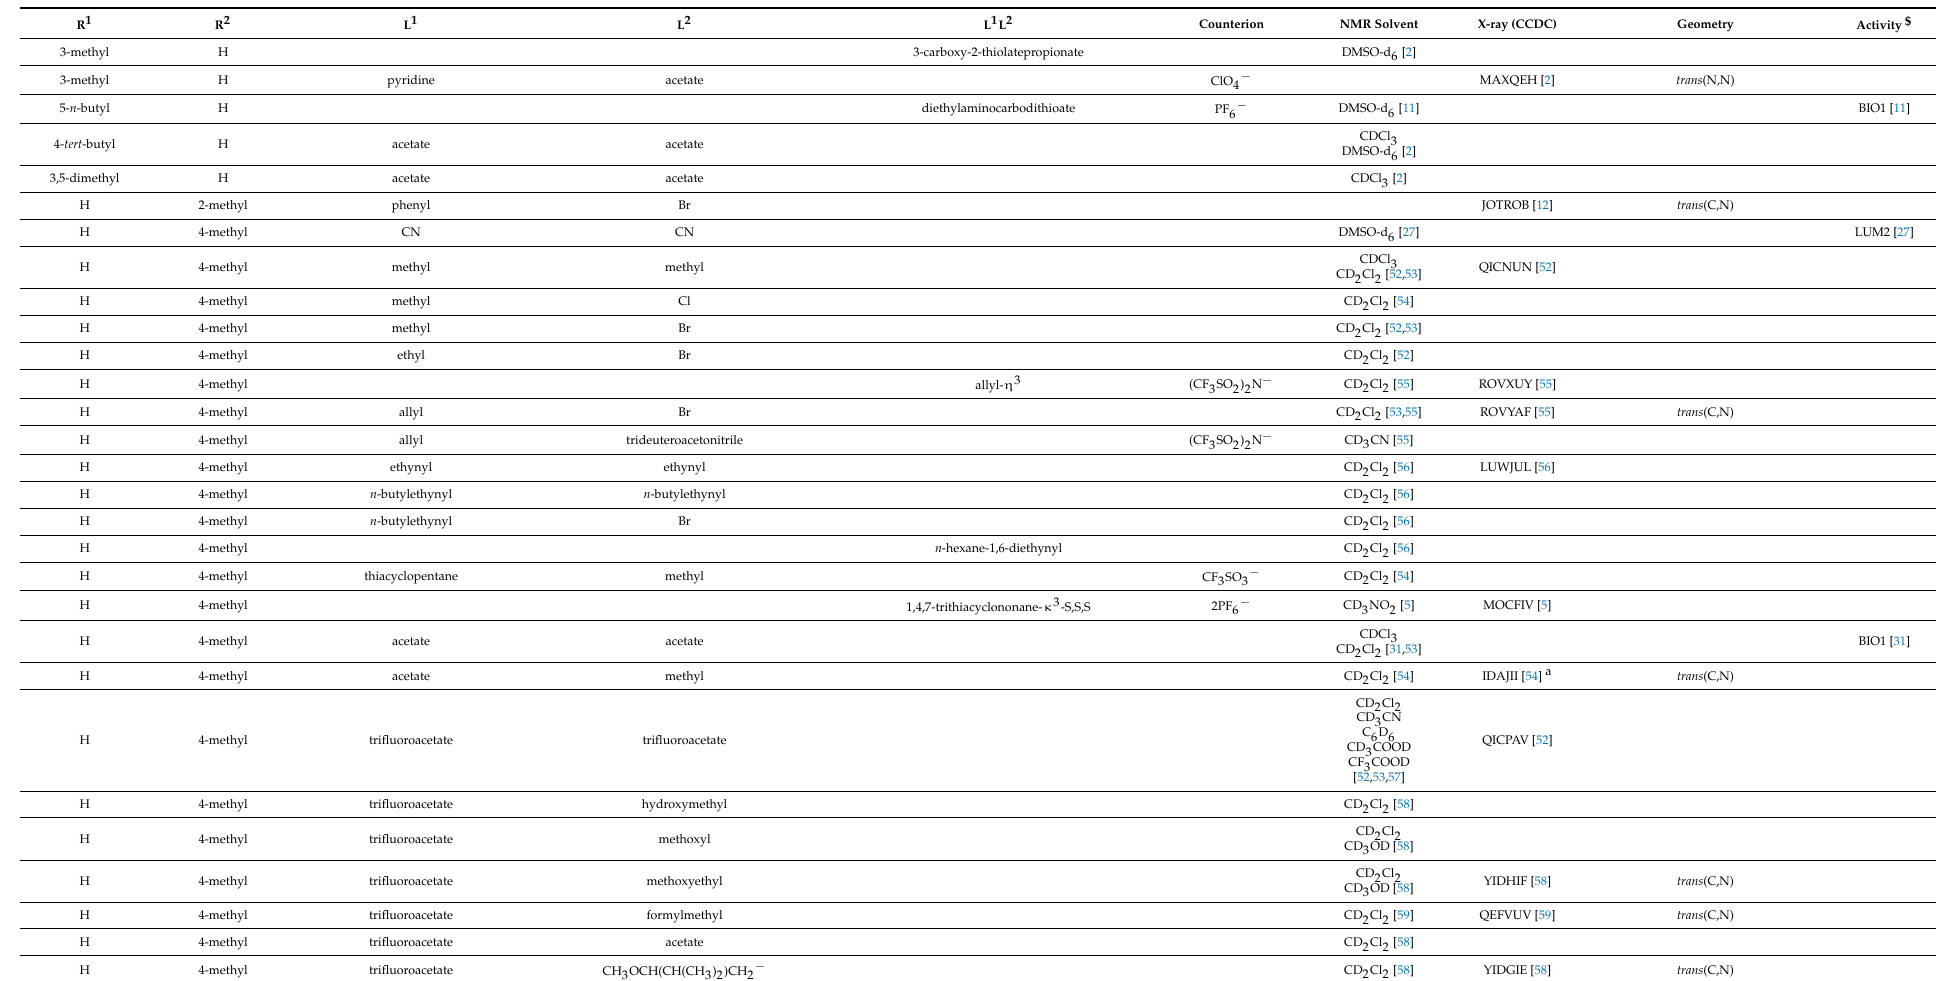
Table 3. NMR and/or X-ray studied [Au(2PPY*)L 1 L 2 ] (in particular, [Au(2PPY*)L 2 ]) or [Au(2PPY*)(L 1 L 2 )] (in particular, [Au(2PPY*)(LL)]) compounds (2PPY*